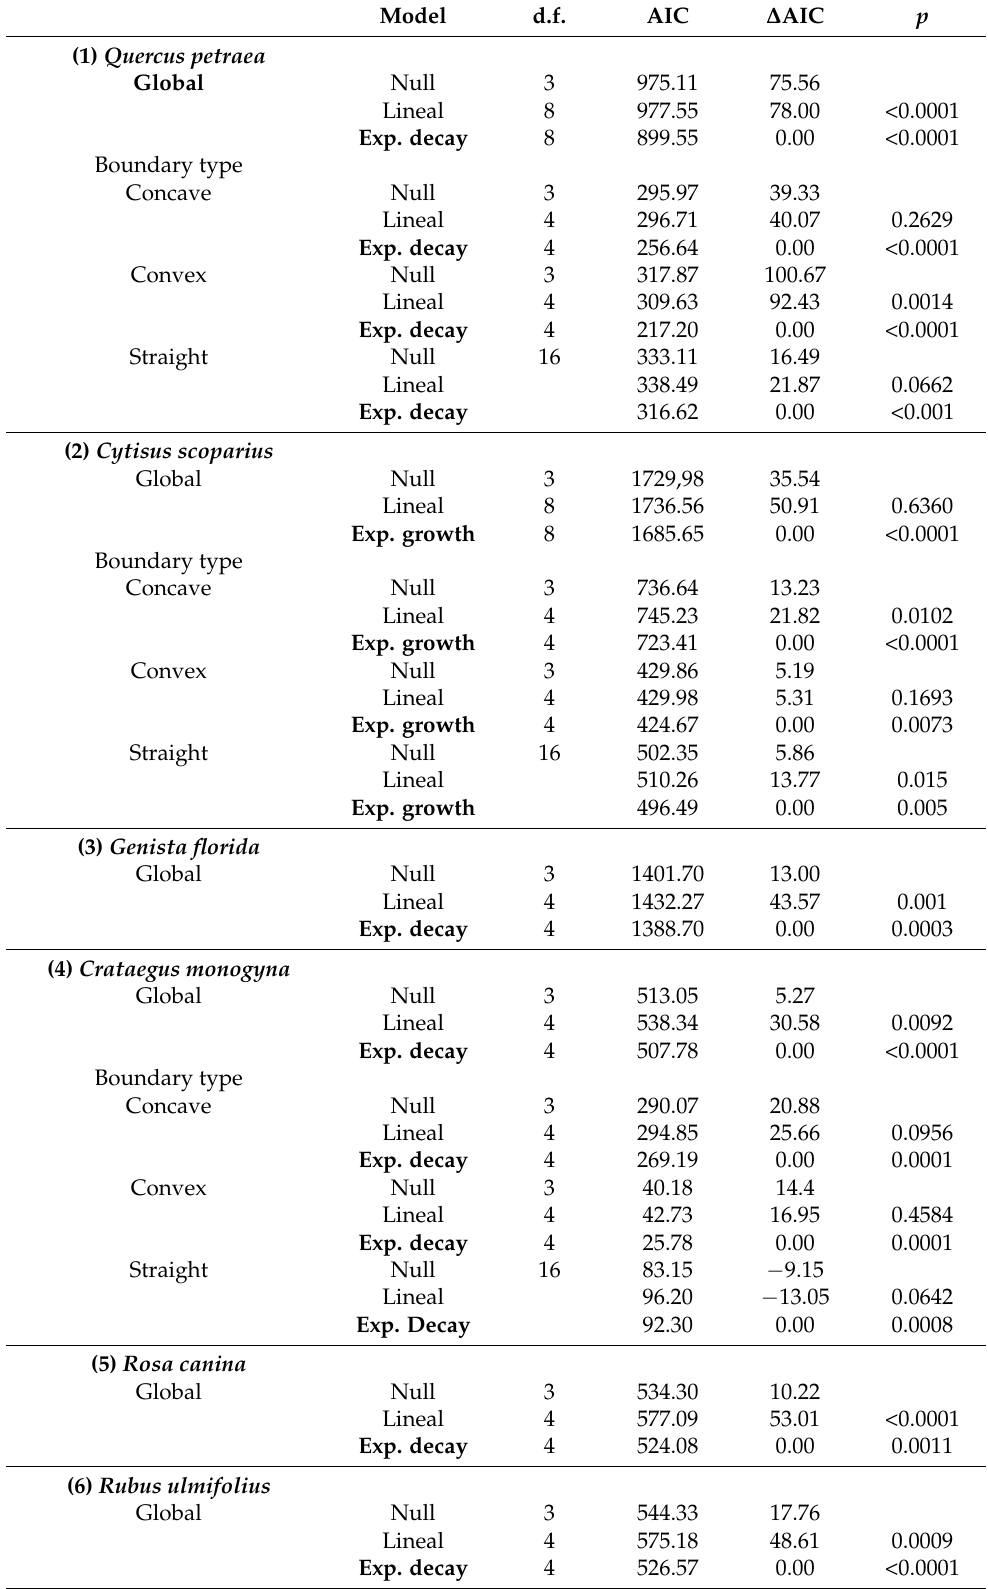
Table A2. Results of Linear Mixed Models (LMM) describing how woody density in mines varied with increasing distance to the forest edge. The best models (lowest AICs) are highlighted in bold. p indicates the significant differences between the null and the alternative models after the